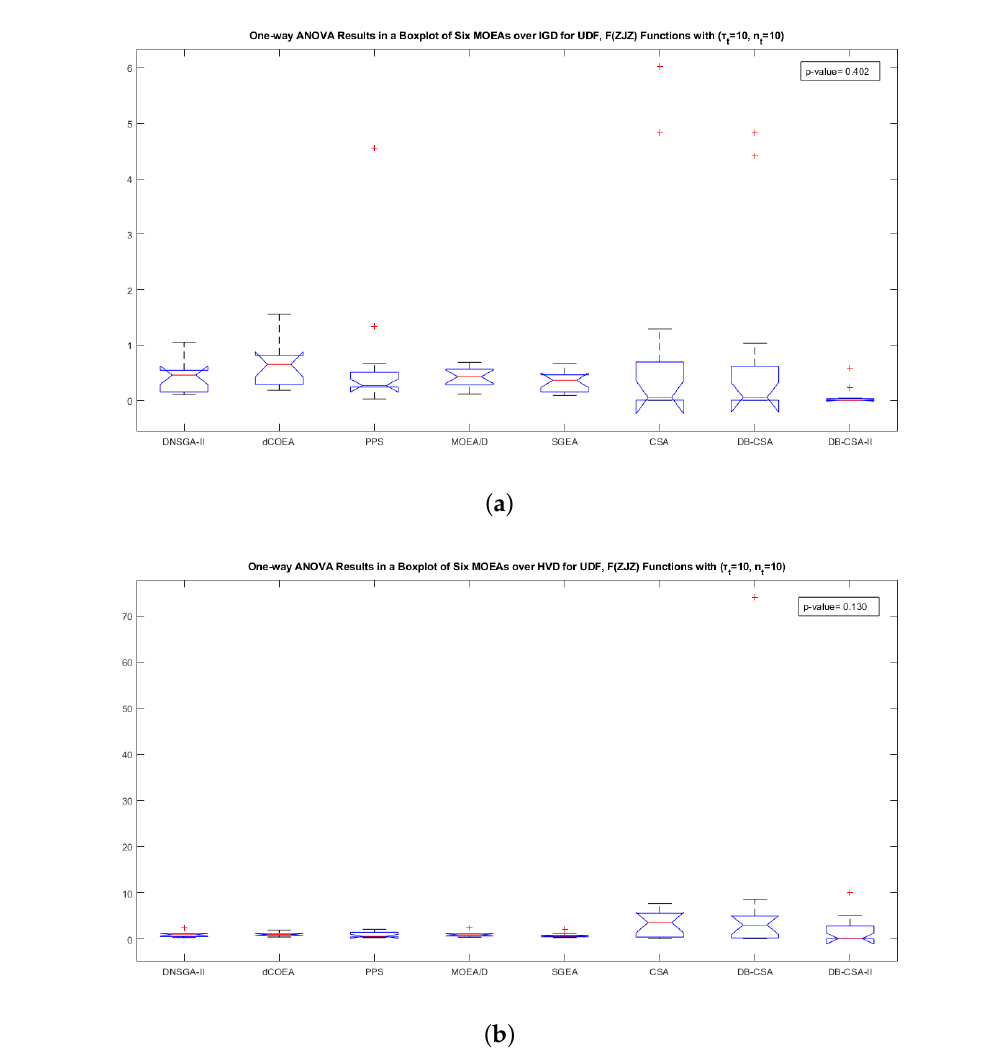
Figure 8. One-way ANOVA Box-plots of 6 MOEAs over ( a ) IGD and ( b ) HVD of UDF, F function for moderate ( τ t = 10, n t = 10) environmental